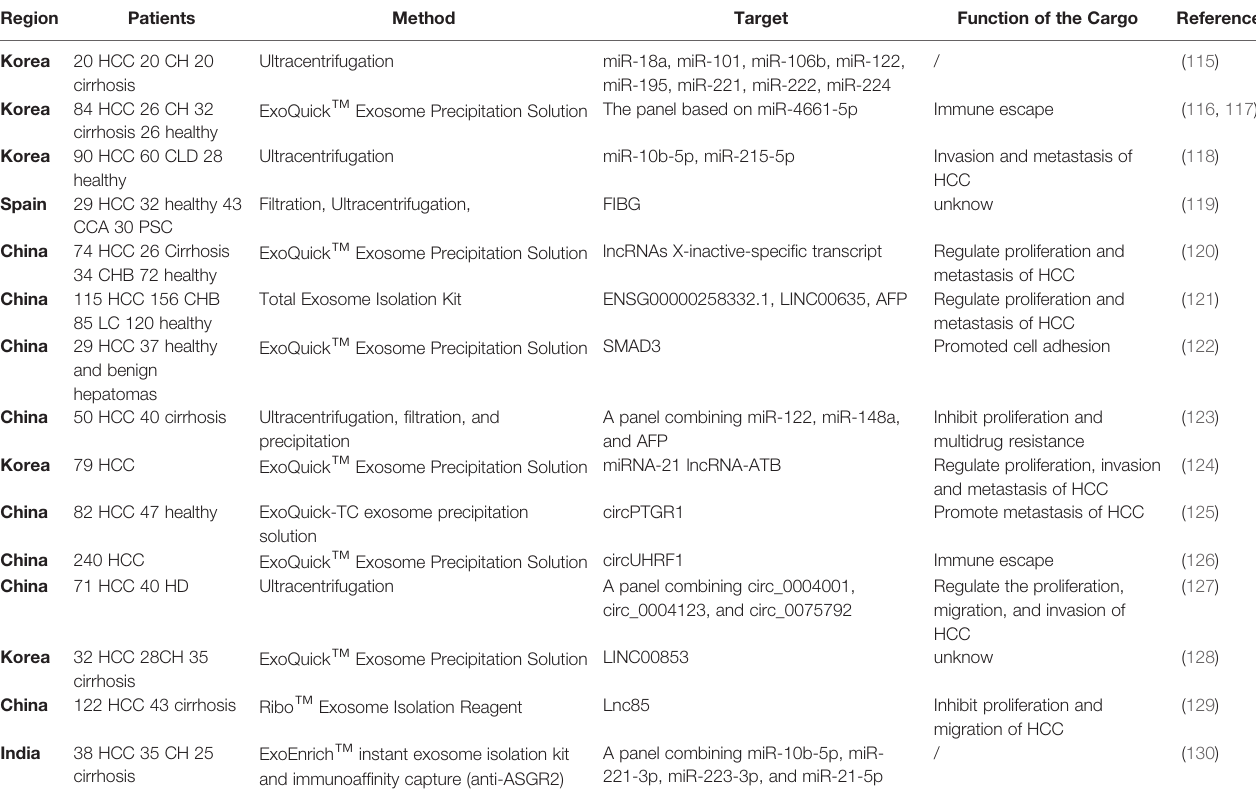
TABLE 3 | Clinical applications of exosomes in